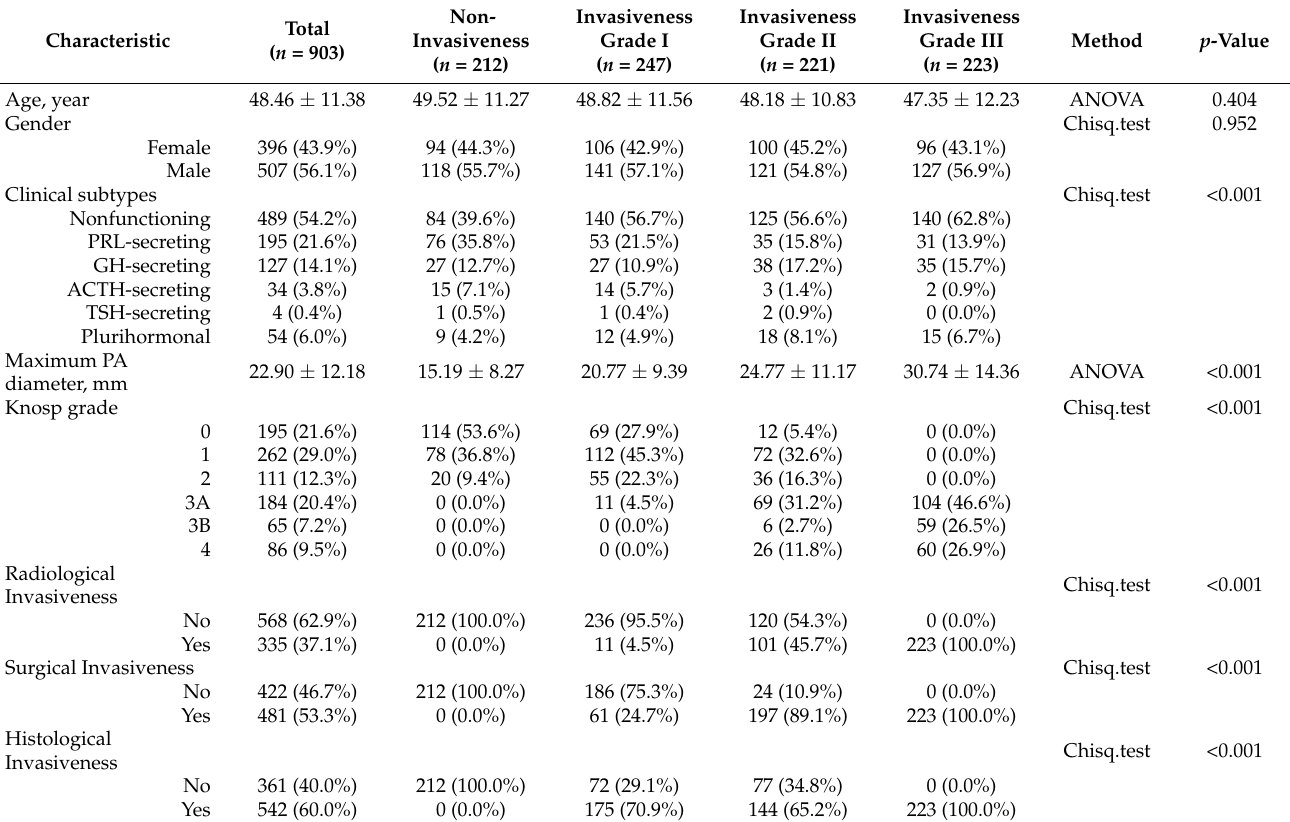
Table 2. Characteristics of different invasiveness grades (Invasiveness Classification